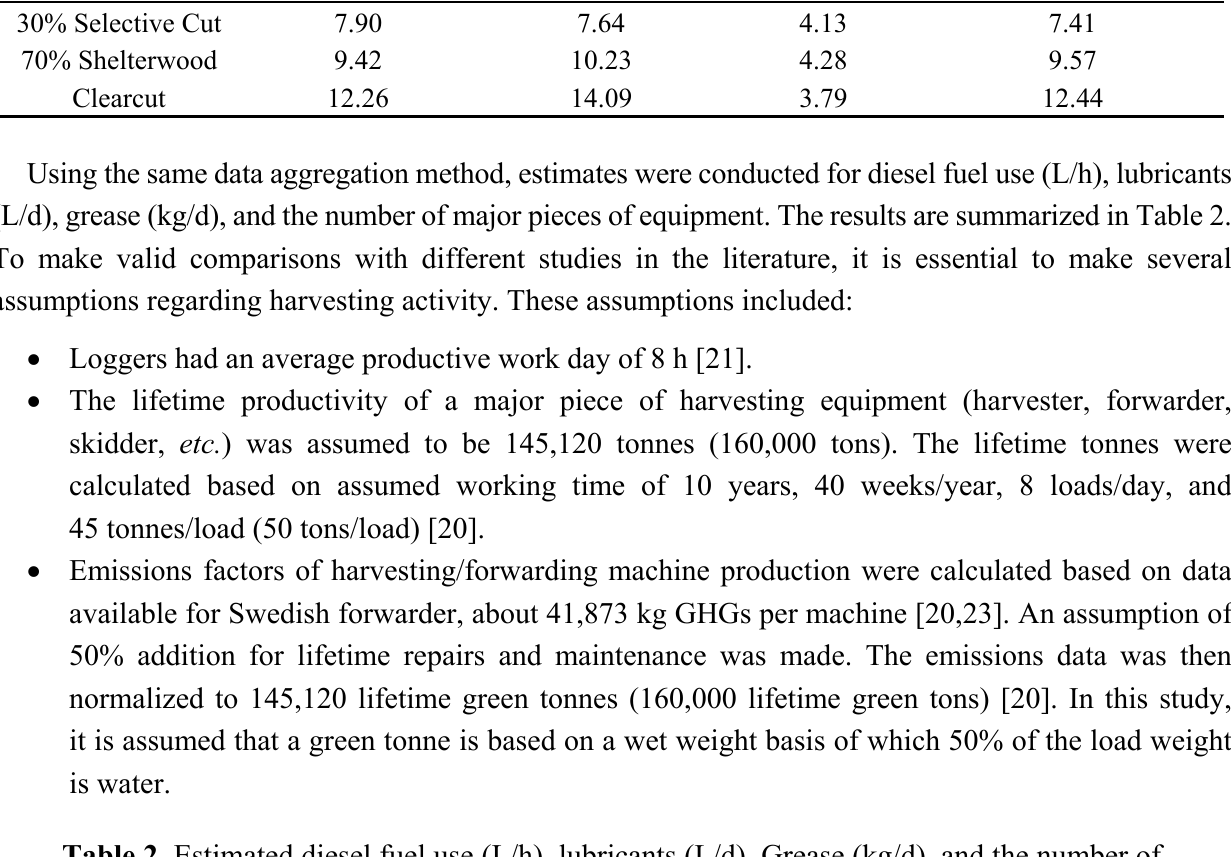
Table 2. Estimated diesel fuel use (L/h), lubricants (L/d), Grease (kg/d), and the number of major pieces of